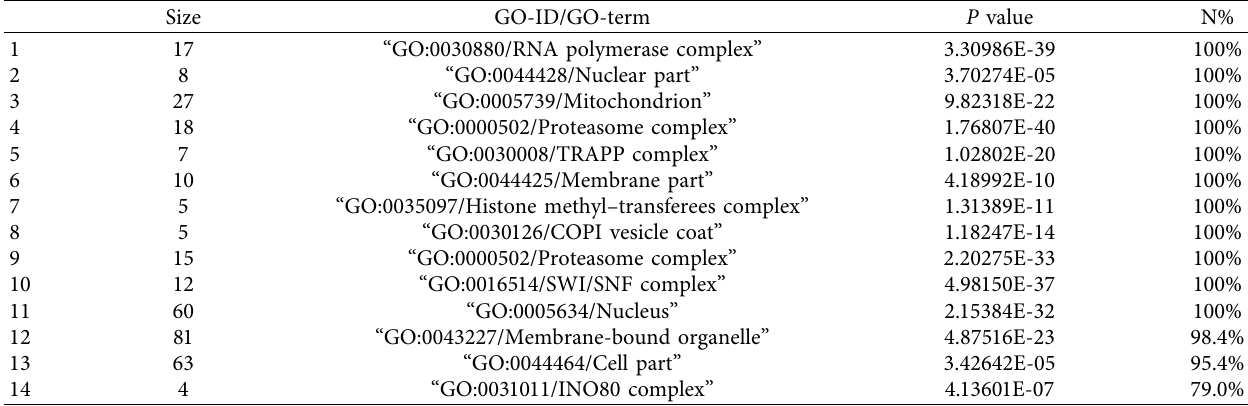
Table 13: Some clusters in the Collins network with the lowest p value with GO component.